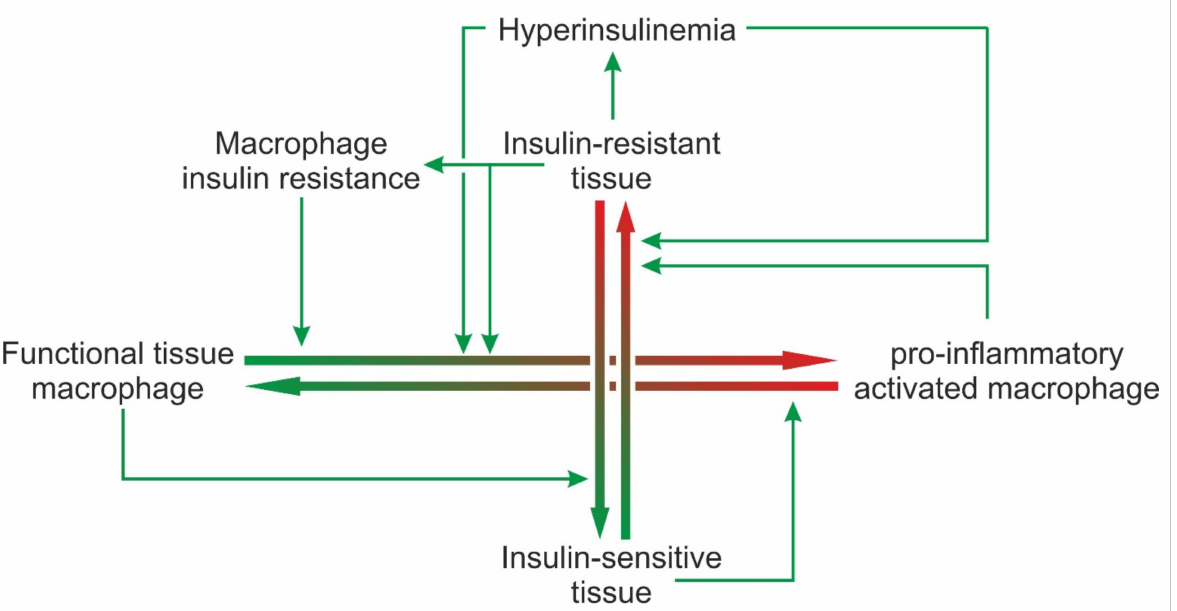
Figure 3. Schematical overview of the mutual interrelation between macrophage differentiation, tissue insulin resistance and hyperinsulinemia. Pro-inflammatory macrophage activation, tissue insulin resistance and hyperinsulinemia are mutually interrelated and may promote each other in vicious feed-forward cycles (green to read arrows). On the other hand, insulin-sensitive tissues provide cues to shape functional tissue macrophages which in turn provide signals that enhance tissue insulin sensitivity (red to green arrows). For details see concluding